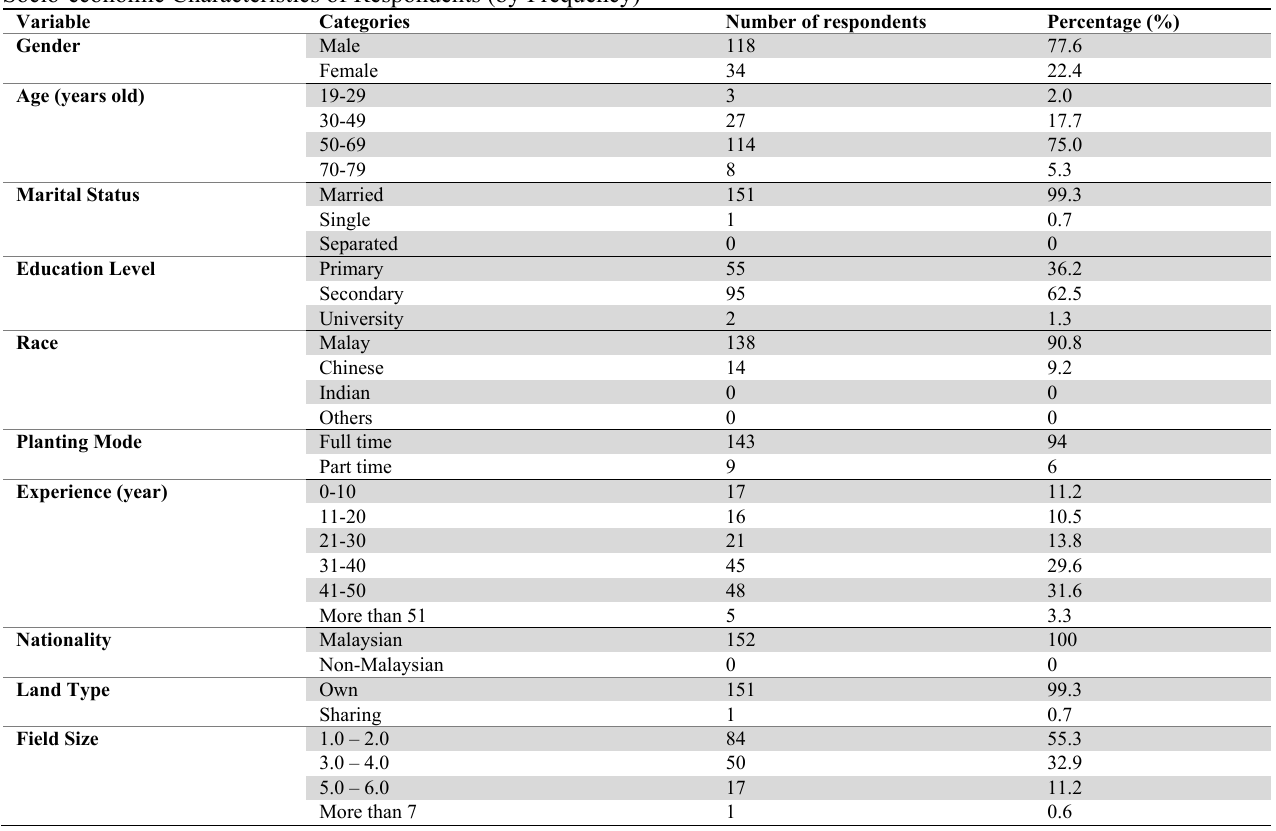
Socio-economic Characteristics of Respondents (by